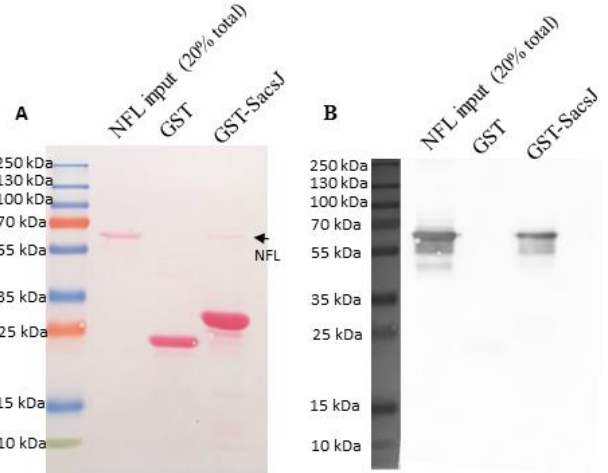
Figure 3. SacsJ directly interacts with NFL in vitro. ( A ) GST pulldown assay of soluble recombinant NFL with GST-SacsJ, or GST as control. ( A ) Ponceau red staining of the nitrocellulose membrane transferred from SDS-PAGE. Lanes are: NFL input—20% of total amount of NFL used in the pulldown assay; GST: GST incubated with NFL; GST-SacsJ: GST-SacsJ incubated with NFL. Bands stained by Ponceau red in each lane are NFL, GST, GST–SacsJ and NFL (small arrow). ( B ) Immunolabelling of the nitrocellulose membrane shown in ( A ) using anti-NFL antibody (NR4, 1/1000) demonstrating that the small band identified in ( A ) using GST-SacsJ as bait is indeed NFL